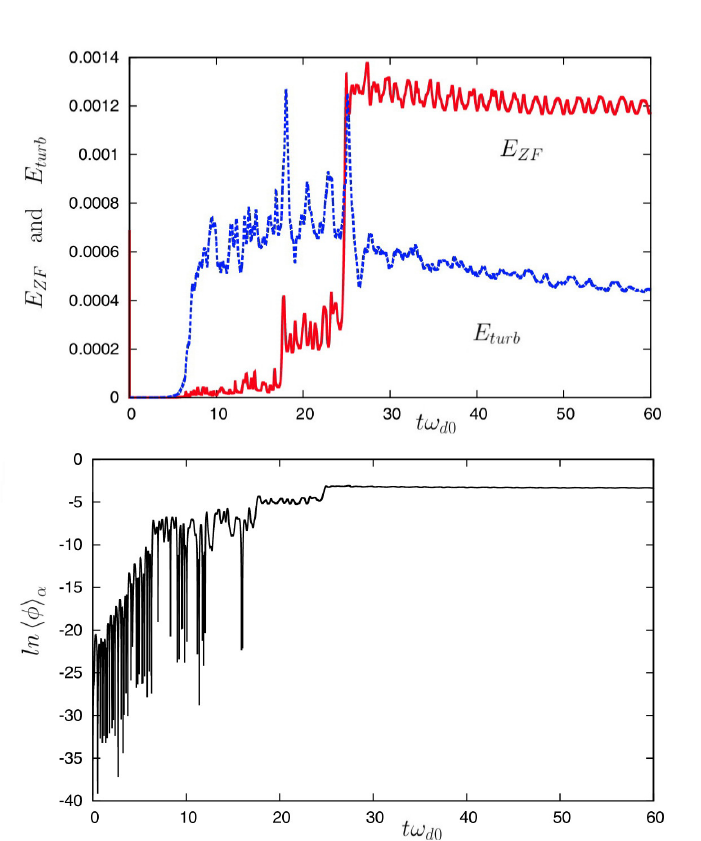
Figure 4. On the top panel: temporal evolution of the quantities E ZF (in red and in solid line) and of the turbulent component E turb (now in blue and in dotted line) for C i = 0.875 for a long time. On the bottom panel: the corresponding time evolution of the mean electric potential in a logarithmic scale. by a weak growth-rate for time t ω d 0 < 18, followed by a first resonant peak at t ω d 0 (cid:39) 18 and finally a The plot of (cid:104) φ (cid:105) was taken at ψ = 1 (in (cid:52) ψ α 2